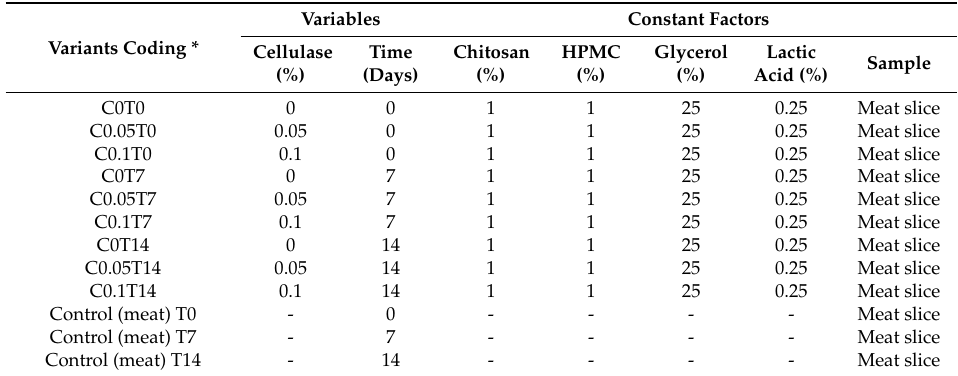
Table 2. Experimental